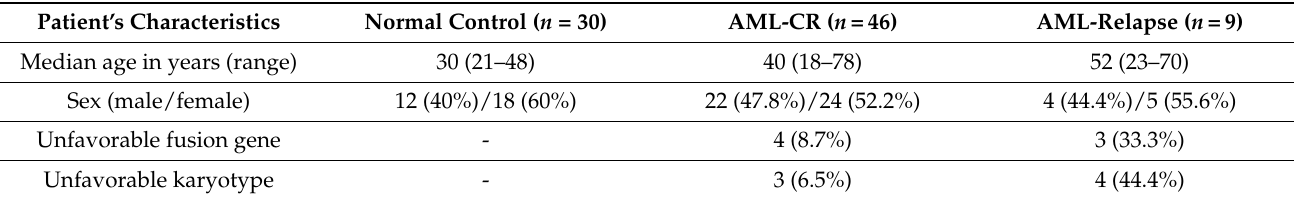
Table 2. Patients’